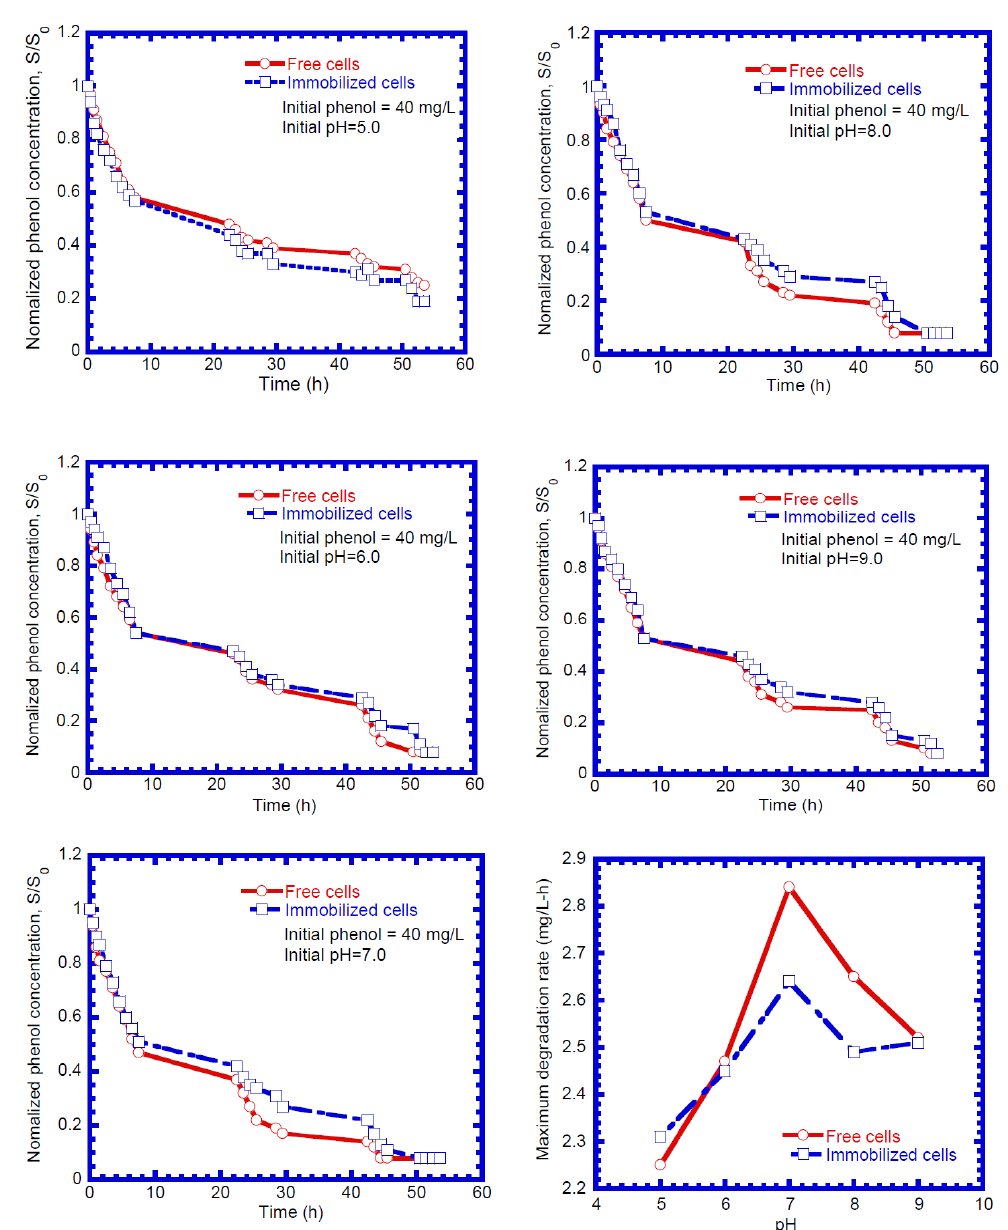
Figure 3. E ff ect of pH on phenol degradation by free and immobilized Figure 3. Effect of pH on phenol degradation by free and immobilized cells.